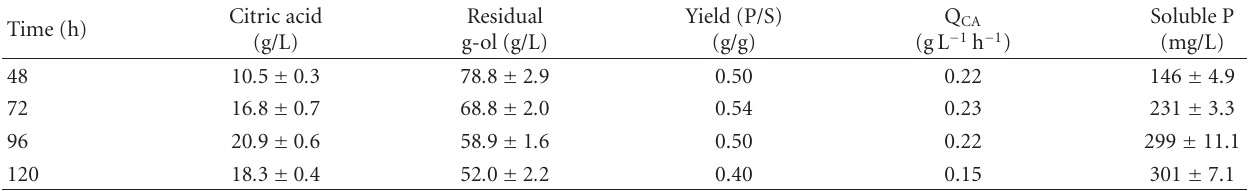
Table 2: Citric acid production and simultaneous animal bone char solubilization by k-carrageenan-entrapped cells of Yarrowia lipolytica employed in a single-batch fermentation